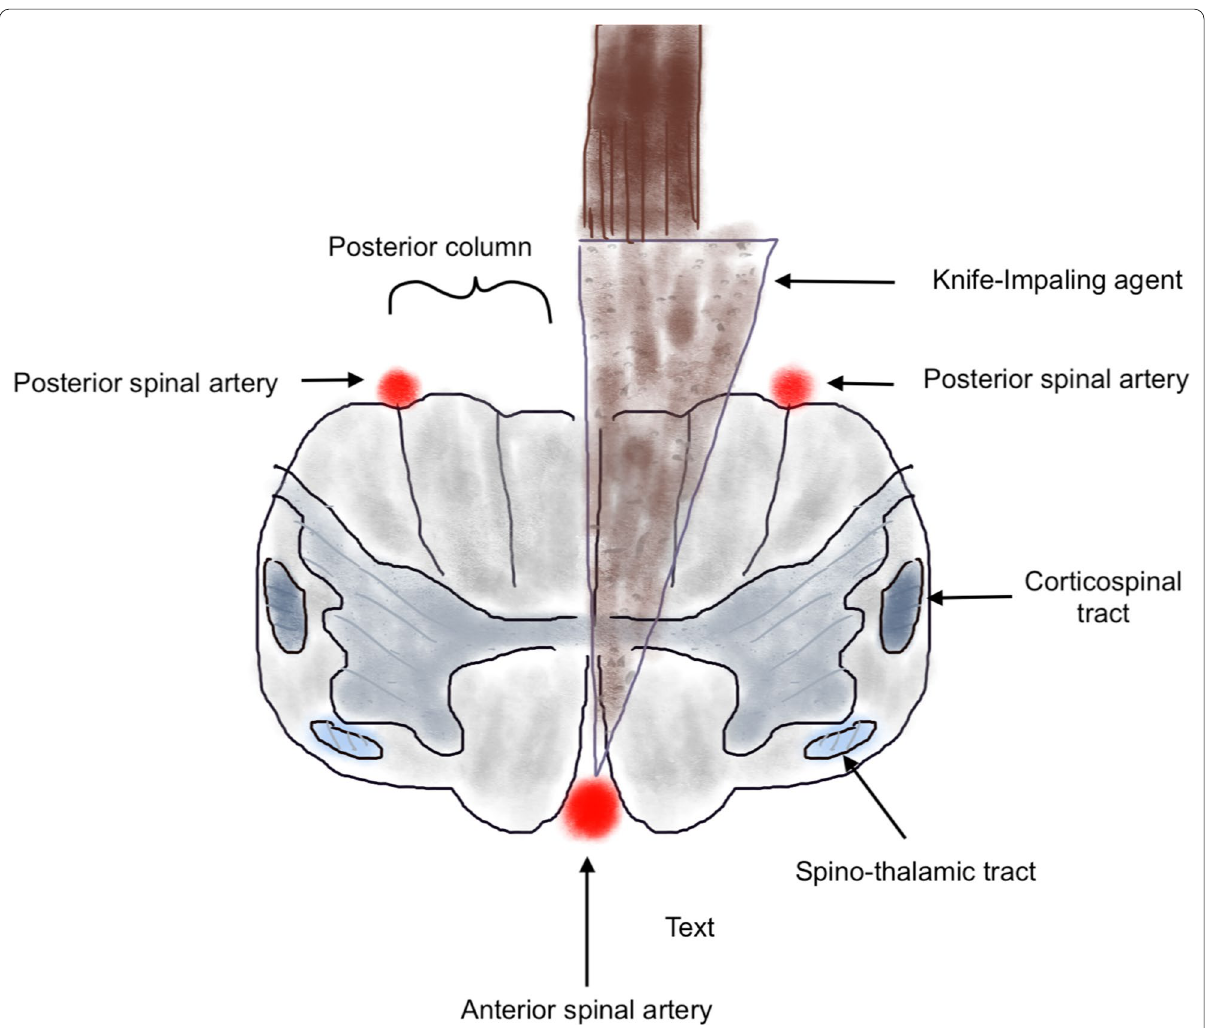
Figure 4 denotes the usual trajectory of the impaling agent; in this case—Knife or dagger. It is noteworthy that impact and depth usually decide the secondary deficits. Even though the primary picture may be of complete cord transection (Fig. 5), many times it may be deluded in view of spinal shock. In our cases by post-operative day 2 both patients regained their pressure and vibration sense which denotes injury